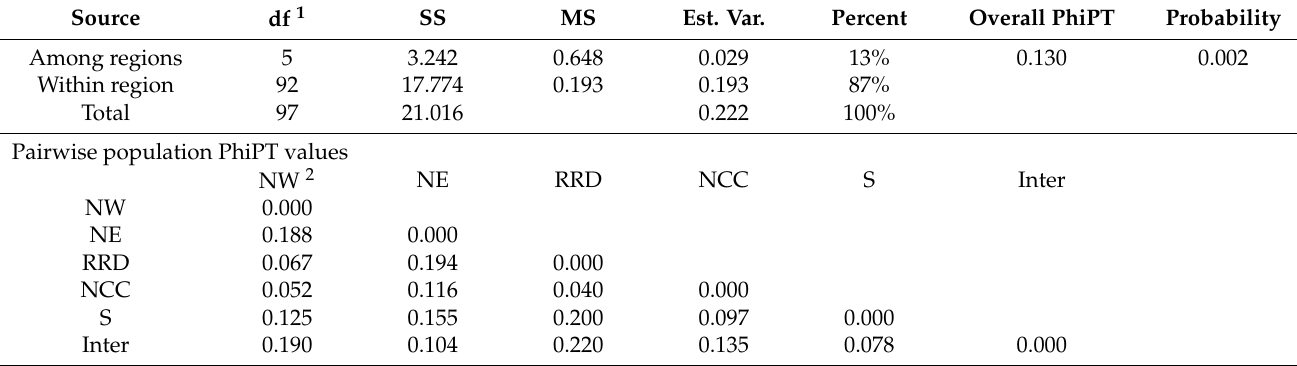
Table 2. Summary of AMOVA and pairwise comparison using PhiPT values among and within